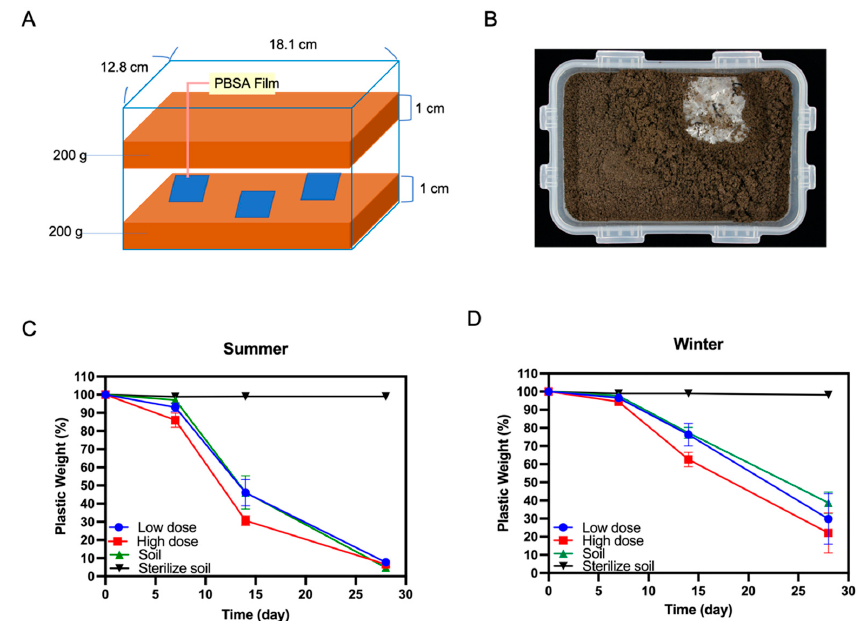
Figure 6. Soil burial test for biodegradation of PBSA films. ( A ) Schematic diagram of the device for